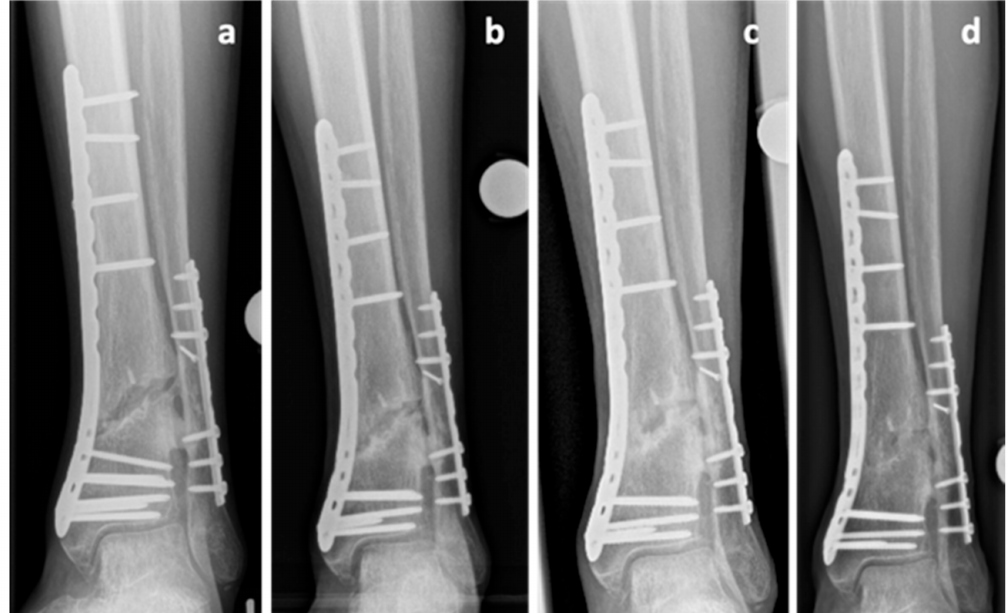
Figure 4. Case 4, x-rays showing a nonunion 29 months after the initial injury at the initiation of the teriparatide therapy ( a ). Serial x-rays after 3 and 15 months of teriparatide treatment showing gradual callus build-up ( b , c ). Radiological and clinical union was achieved 4 years after the initial injury ( d